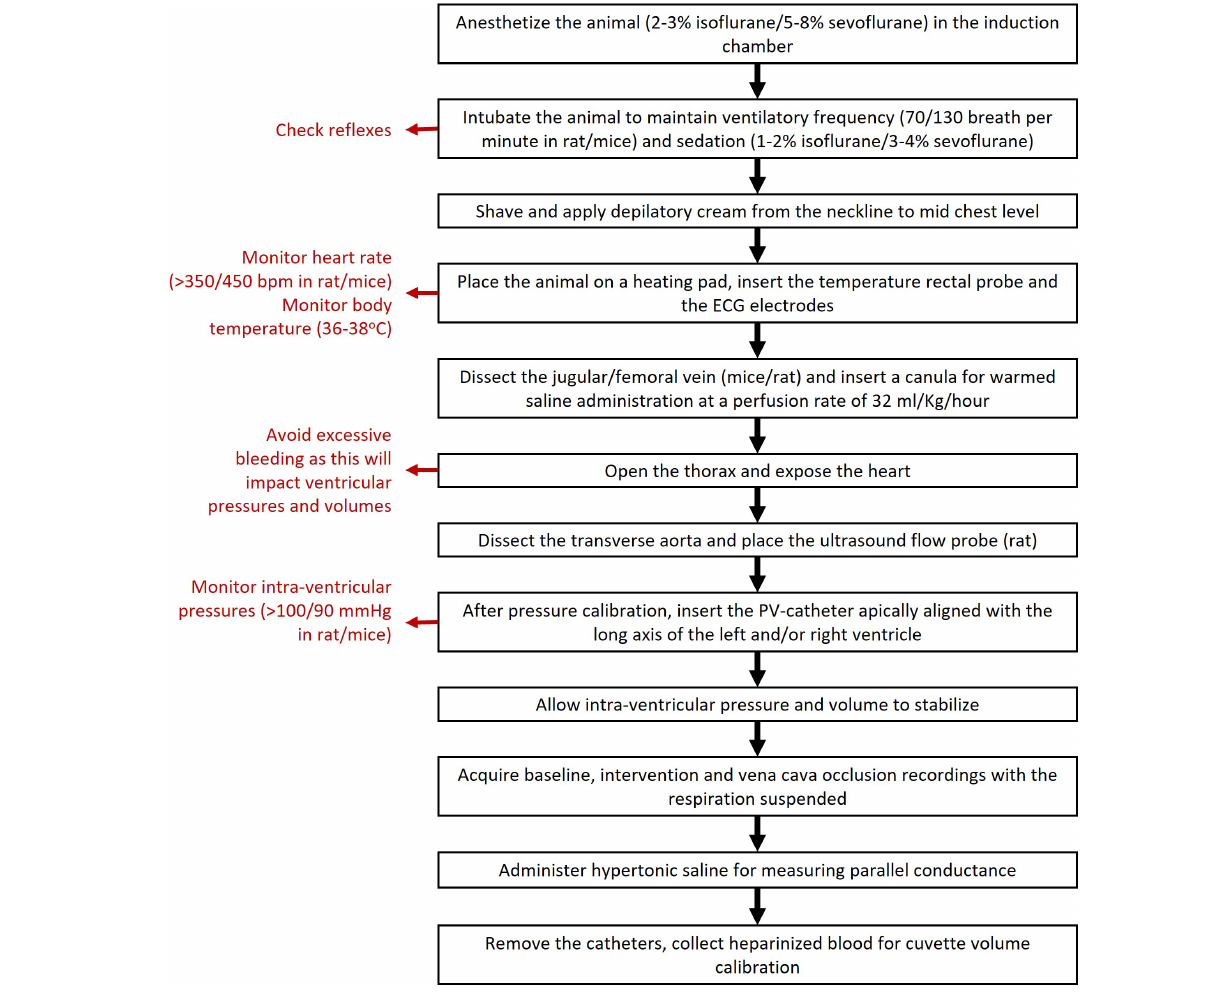
FIGURE 1 | Main steps and recommendations (in red) for PV-loops